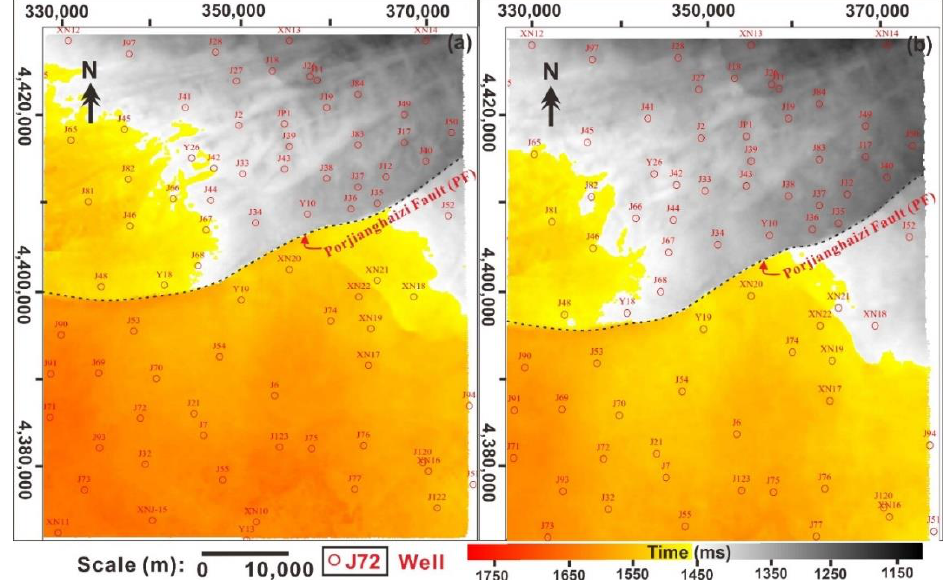
Figure 6. Horizon interpolation. ( a ) T9d, and ( b ) T9e.